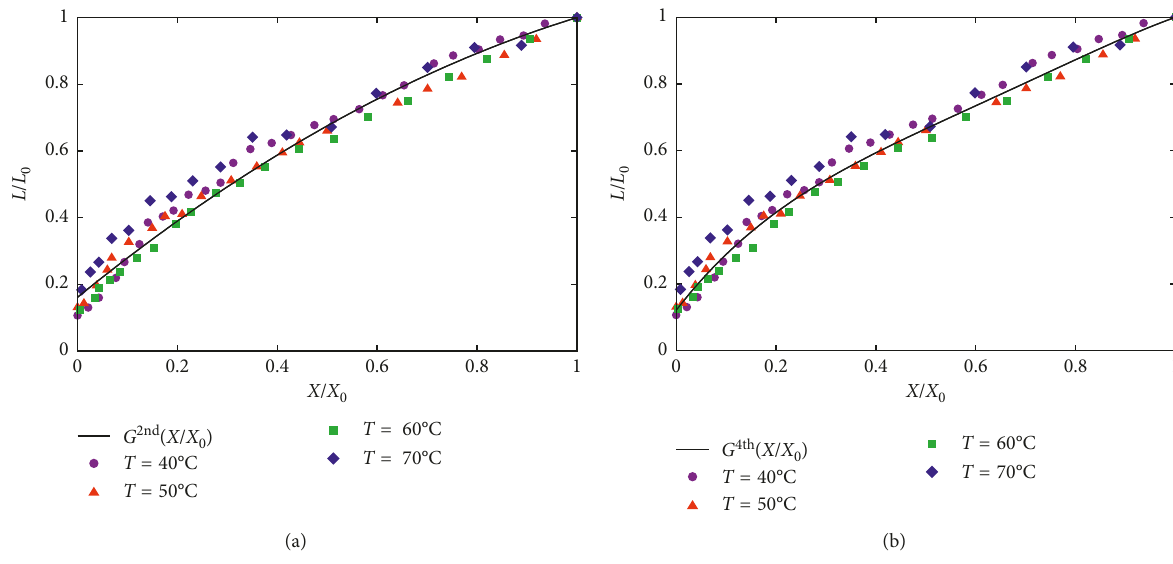
T 40 , 50 , 60 , and 70 ° C. Least-square (cid:31)